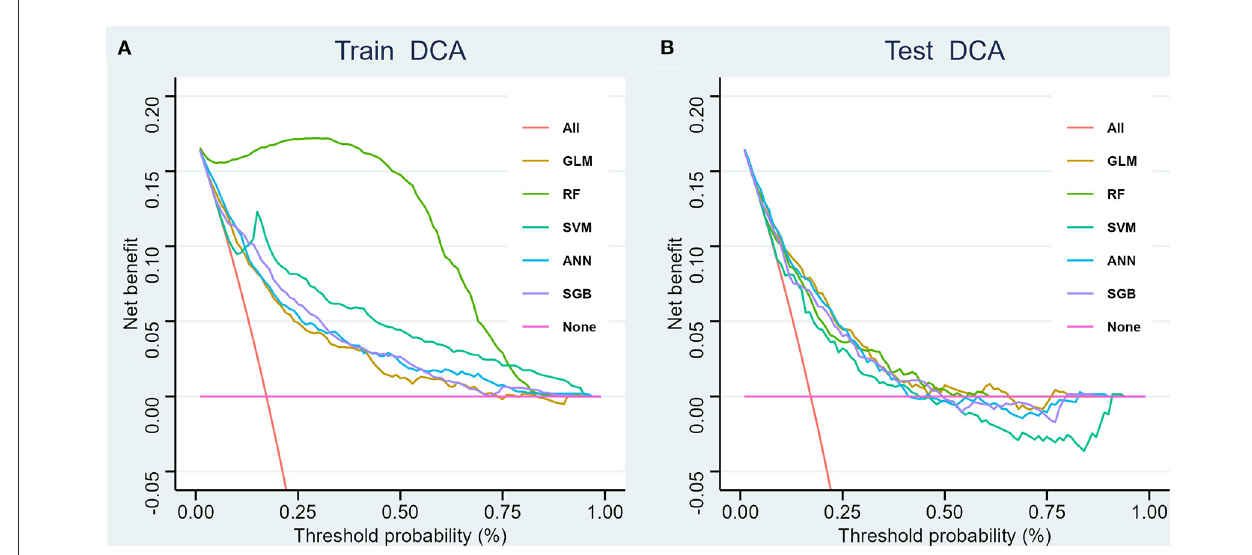
FIGURE4 Decision curve analysis for four models, training set (A) and test set (B) . GLM, generalized linear model; RF, Random Forest; SVM, support vector machine; ANN, artificial neural network; SGB, Stochastic Gradient